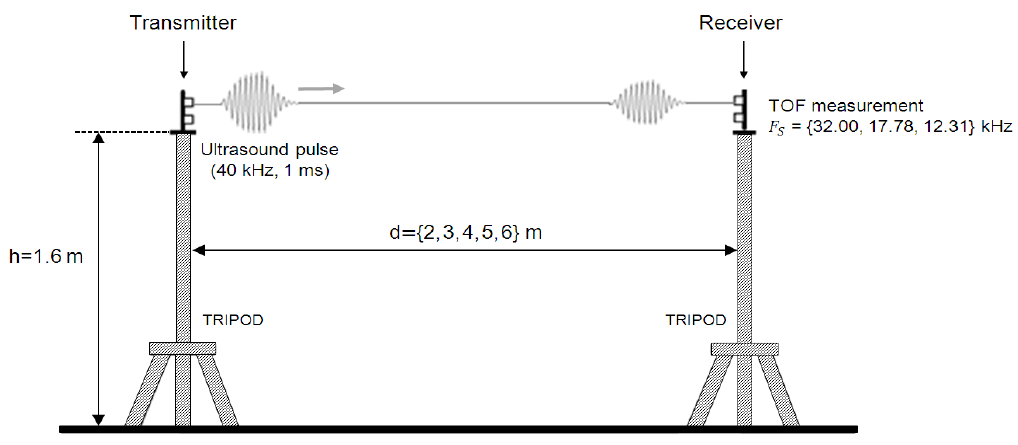
Figure 8. Illustration of the test-bed used in the distance measurements. A transmitter node and a receiver node are placed one in front of the other using a pair of tripods at a height of 1.6 m above the ground. Different distances in the range of 2–6 m are considered. The distance between nodes is set by using a commercial laser rangefinder of precision ± 1.5 mm. The transmitter node sends periodically an ultrasound pulse of 1 ms by allowing 8 TOF measurements every 3.2 seconds. The receiver node is configured to use the sampling frequencies of 32 kHz, 17.78 kHz and 12.31 kHz. A total of 500 TOF measurements were taken for each distance and each sampling